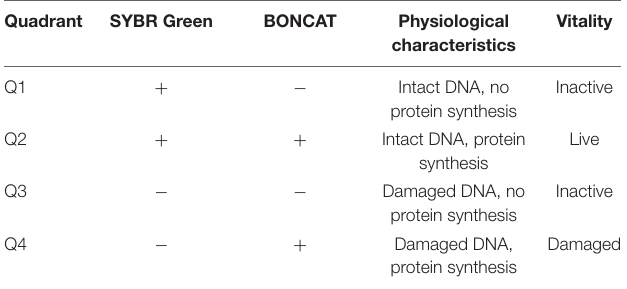
Vitality characteristics